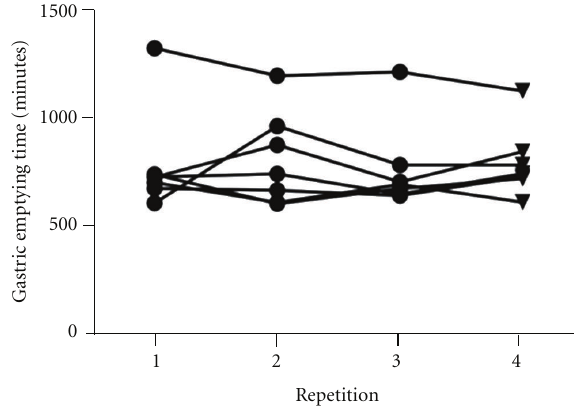
Figure 3: Gastric emptying times before and during treatment with ranitidine. The first 3 repetitions (circles) are before treatment with ranitidine, the 4th repetition (triangles) is during treatment with ranitidine, and there was no significant di ff erence between any of the 4 repetitions ( P = 0 . 6149).